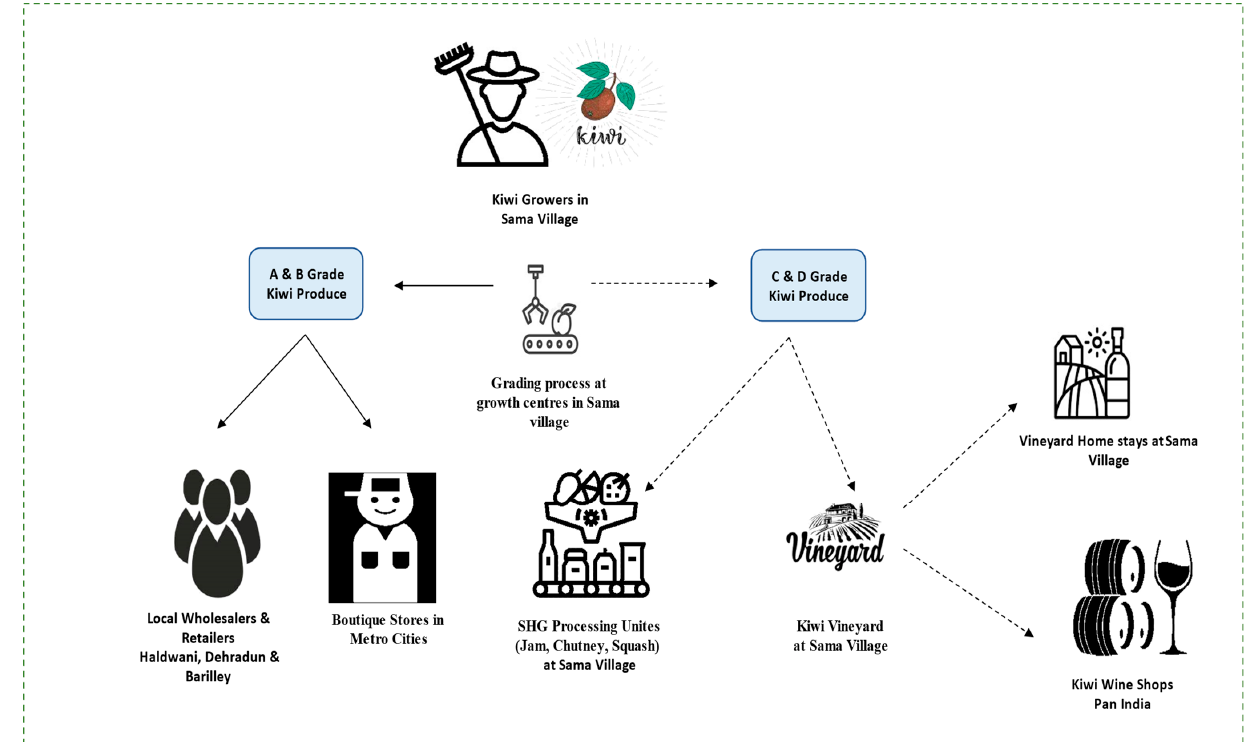
Figure 2. Model post-intervention.